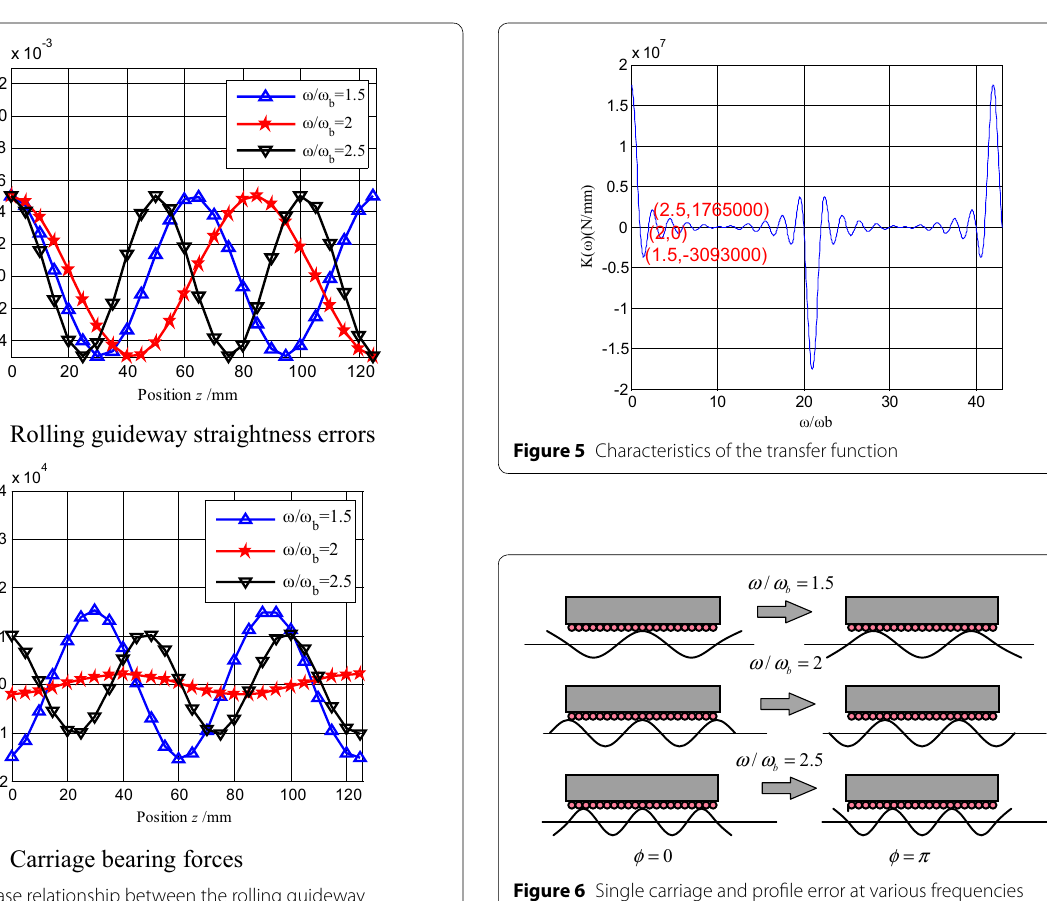
to ω to quantify the effect of the wavelength on kinematic errors, and thus, the transfer function is expressed as the ratio of the amplitude of the bearing forces to that of the guideway errors at different frequencies: